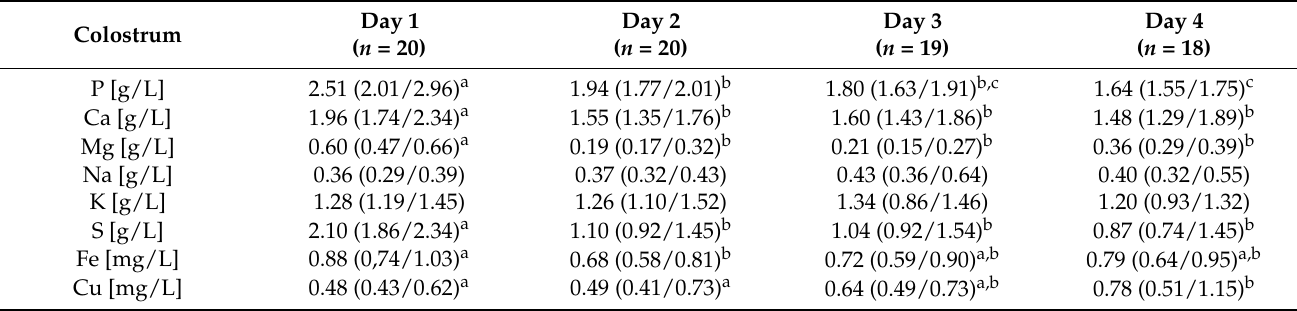
Table 4. Concentrations of macro and trace elements in alpaca colostrum during the four days postpartum, data are provided as median (1st quartile/3rd quartile), significant differences between the days are marked with different indices. Colostrum